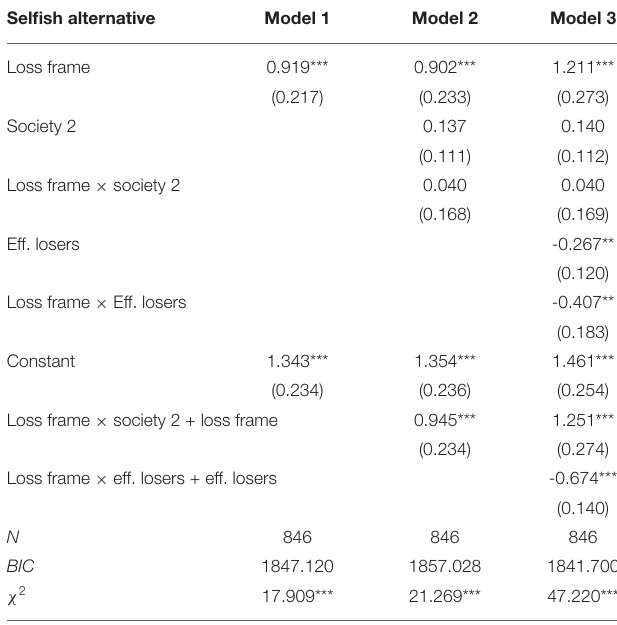
TABLE 4 | Random-effects ordered probit regressions on the probability of approving of the selfish alternative in approval voting